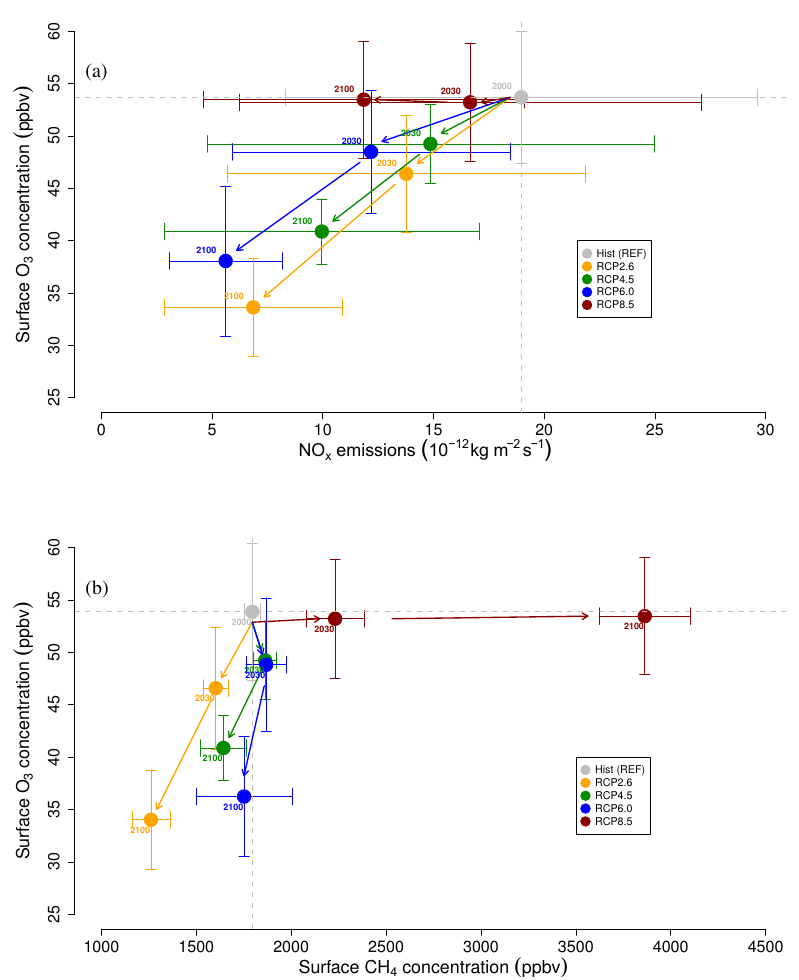
Figure 10. ACCMIP model ensemble mean change in the surface ozone (ppbv) as a function of (a) changes in total NO x emissions (10 − 12 Kgm − 2 s − 1 ) and (b) changes in the surface CH 4 concentration (ppbv), calculated over the Mediterranean Basin domain (see Fig. 1) for the JJA period and for the RCP2.6 (yellow), RCP4.5 (green), RCP6.0 (blue) and RCP8.5 (red) inset box. Error bars indicate multi-model standard deviation. Dashed lines refer to REF values (2000 time slice).